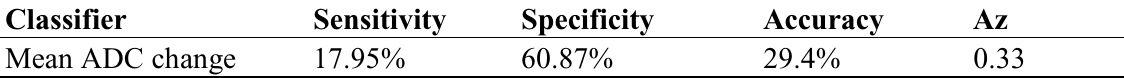
Table 4. Performance of the conventional mean ADC classification method.